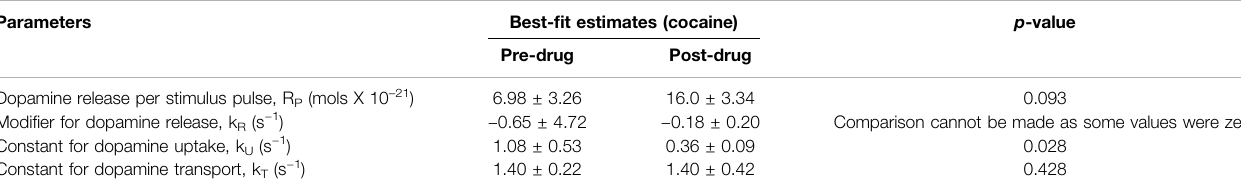
TABLE1| ParameterscalculatedfortheFSCVresponsepre-cocaineand10 minpost-cocaine,basedonthemodelbyWaltersetal.(Waltersetal.,2015).N (cid:1) 4rats.S.E.M. values provided. One-tailed paired t -test was performed. A range is provided in the reference values to account for the slow and fast dopamine domains (dorsal striatal measurements based on medial forebrain bundle